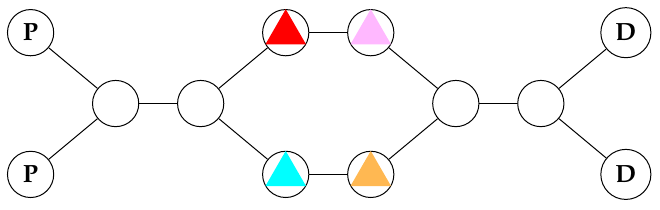
Figure 1. Robots manoeuvering in a